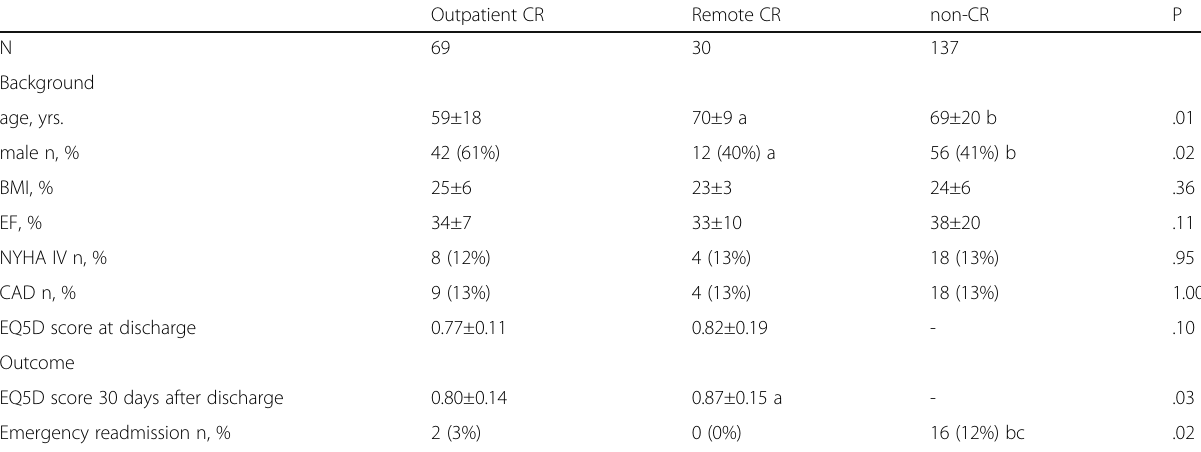
Table 1 Clinical characteristics of patients hospitalized for